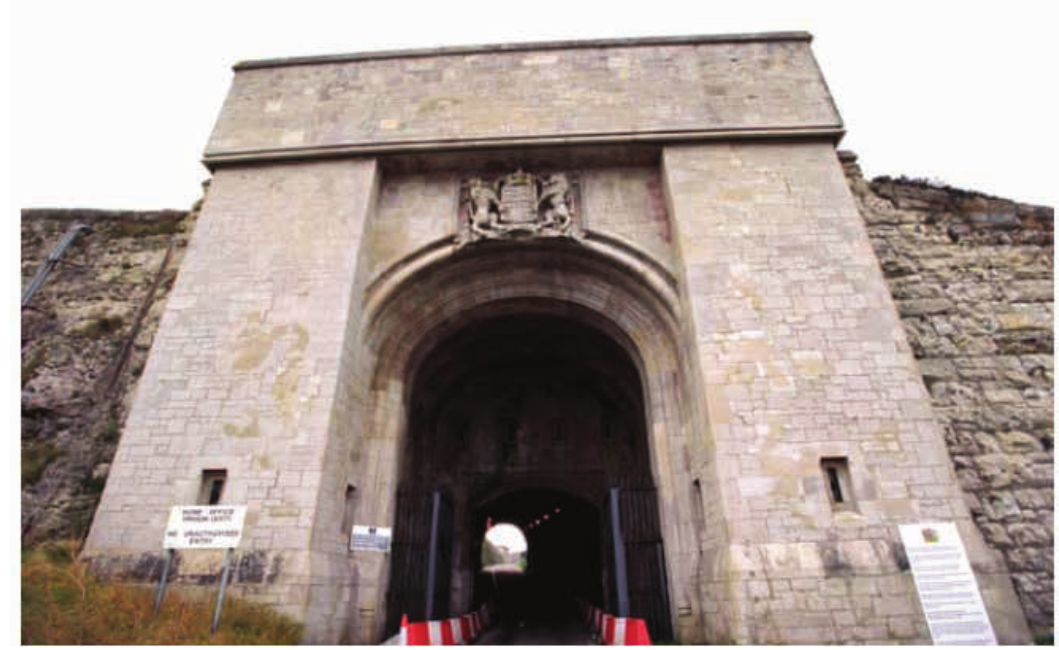
Figure 4: Entrance to the Verne immigration removal centre in Portland, Dorset. ‘The windows look out onto more walls and barbed wire. In here you could be anywhere, and nowhere.’ , Photograph: Alamy (GUA), https://www.theguardian.com/com- mentisfree/belief/2016/aug/11/despair-high-above-the-glittering-waters-of-weymouth-bay (date of last access: 11/01/2019)